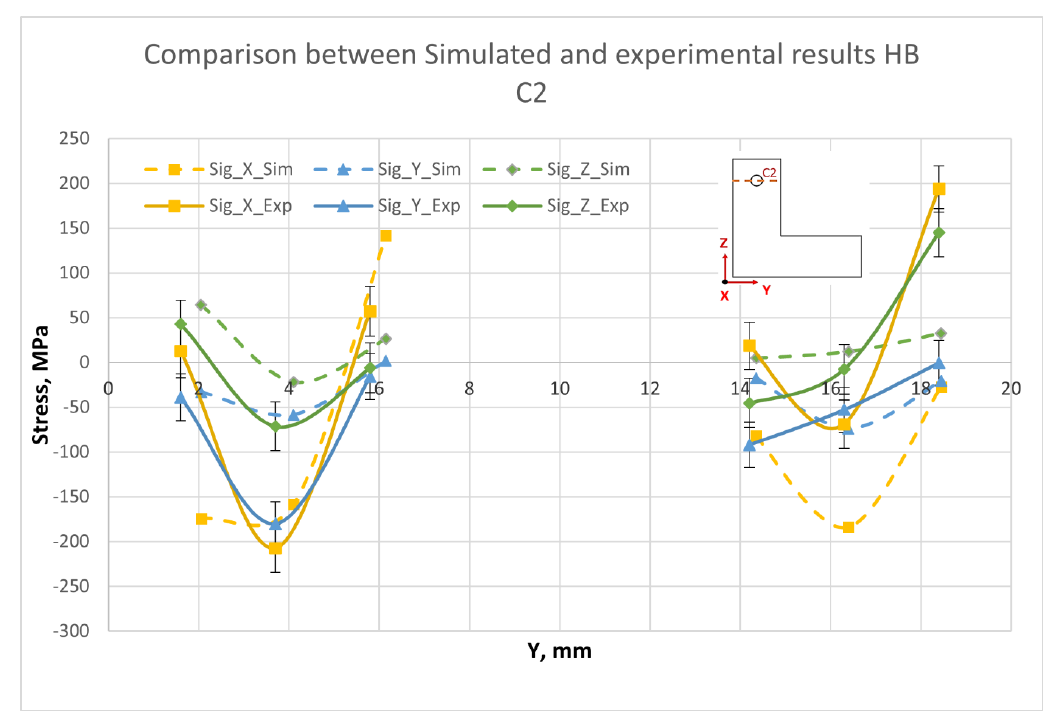
Figure 19. Comparison between experiment and simulation results for HB sample cross-section C2.